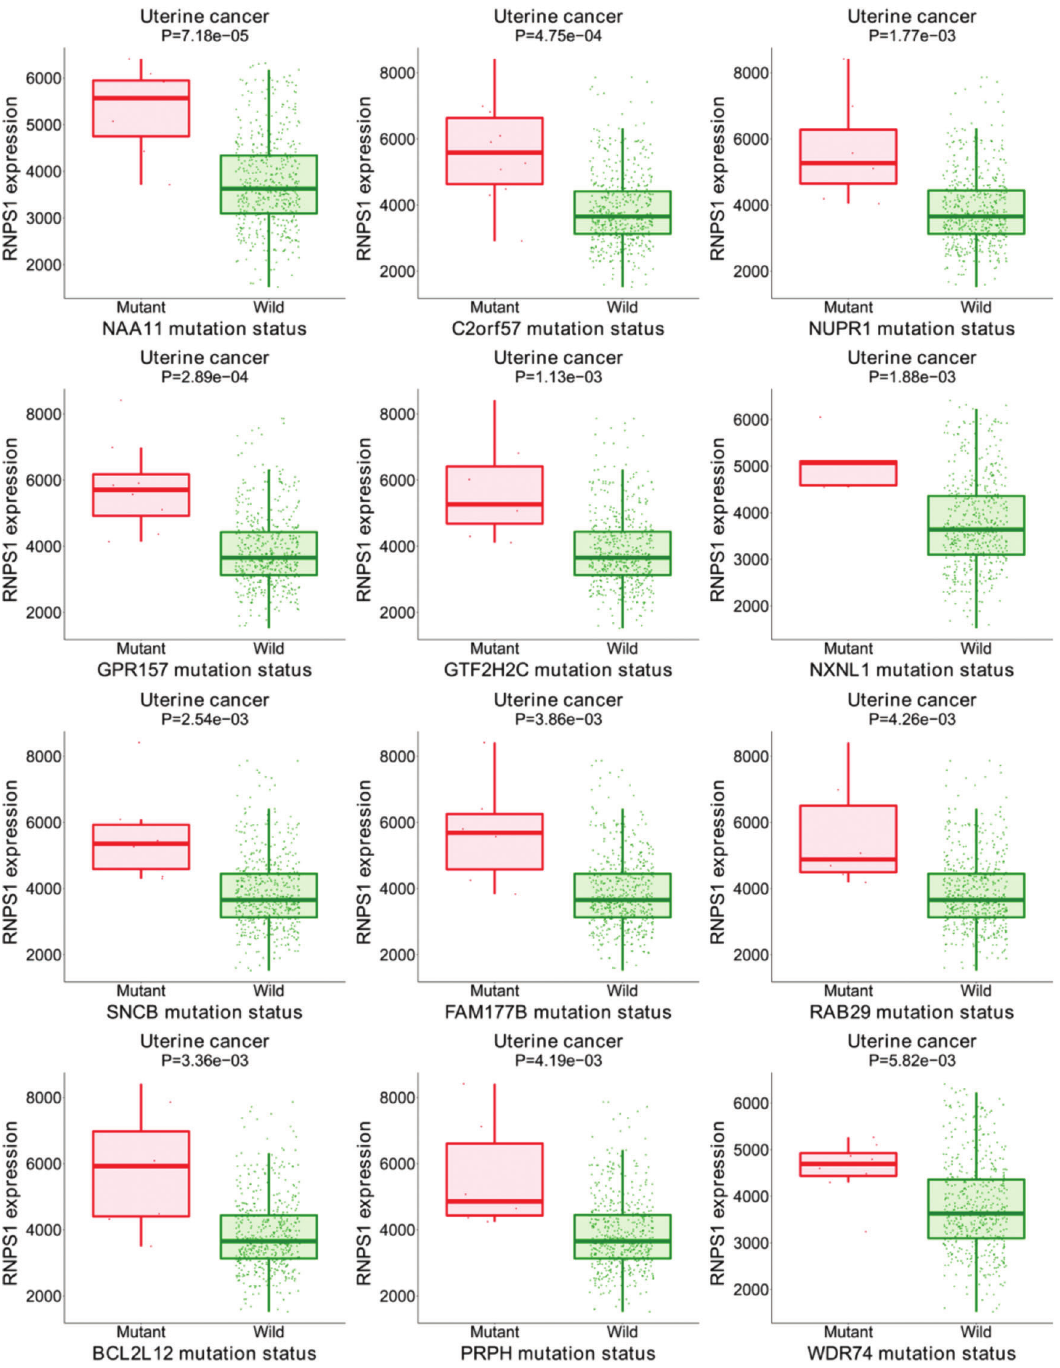
Figure S1 - (A) Expression of RNPS1 in UCEC patients with mutant or wild-type NAA11, C2orf57, NUPR1, GPR157, GTF2H2C, NXNL1, SNCB, FAM177B, RAB29, BCL2L12, PRPH, and WDR74